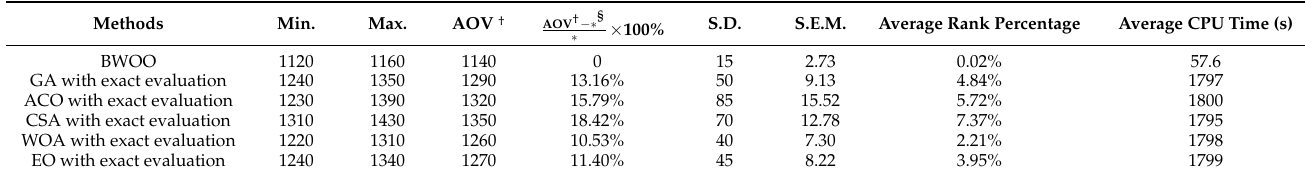
Table 5. Statistic results and average CPU times of six